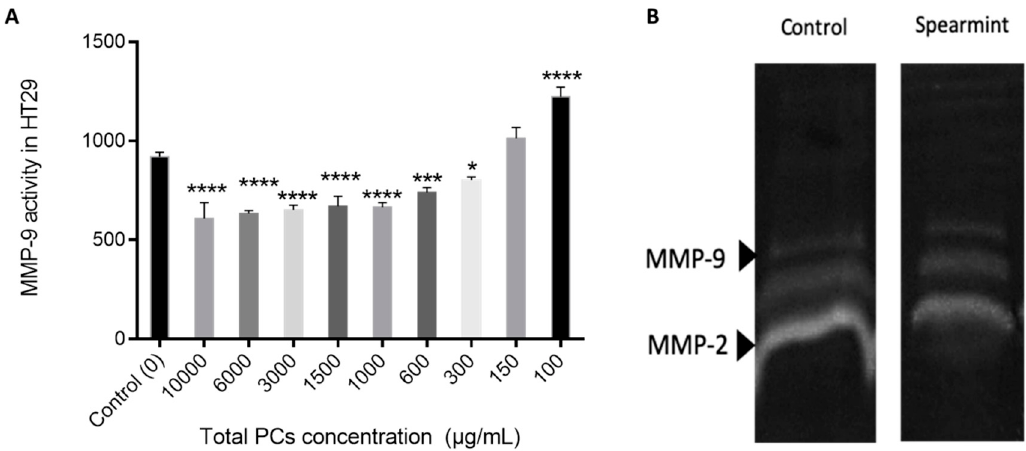
Figure 13. ( A ) E ff ect of spearmint phenolic extract on the MMP-9 activity. * p < 0.05 vs. Control; *** p < 0.001 vs. Control; **** p < 0.0001 vs. Control ( B ) Image from zymographic profiles of MMP-9 Figure 13. ( A ) Effect of spearmint phenolic extract on the MMP-9 activity.* p <0.05 vs Control; *** p < and MMP-2 activities on cells HT-29 0.001 vs Control; **** p ˂ 0.0001 vs Control ( B ) Image from zymographic profiles of MMP-9 and MMP- 2 activities on cells HT-29 medium.